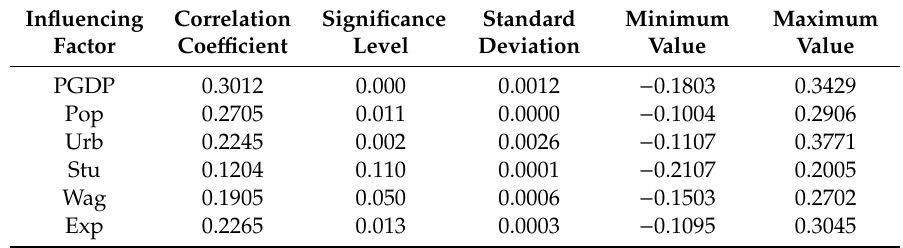
Table 4. Quadratic assignment procedure (QAP) correlation analysis of the influencing factors of spatial correlation network of health resource agglomeration capacities in